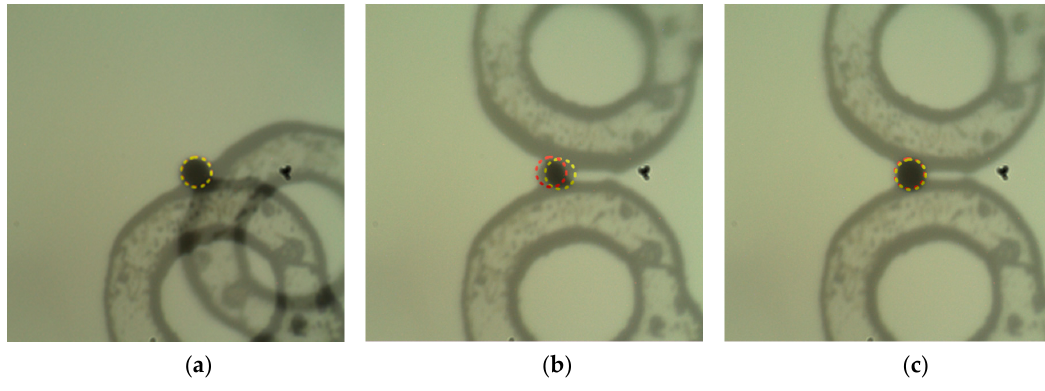
Figure 7. The on-axis viewer images of a 20 μ m diameter ruby sphere mounted on a MiTeGen loop and centred on the φ -axis rotation at the height to bring the sample onto the ω rotation axis. ( a ) An overlay of images with φ at 0° and 180°, and with ω = 0°. The ruby sphere is indicated by the red dashed circle at φ = 0° and the (overlapping) yellow dashed circle at φ = 180°. ( b ) The overlay of images with ω = 0° and φ = 0° (ruby sphere indicated by red dashed circle) and ω = 180° and φ = 0° (ruby sphere indicated by yellow dashed circle) with no correction applied. The displacement of the position of the ruby sphere is 7.5 μ m along the direction of the ω -axis (horizontal). ( c ) The overlay of images with ω = 0° ( φ = 0°) and ω = 180° ( φ = 0°) with the sphere-of-confusion correction applied. The translation of the centre of the ruby sphere (indicated by the red and yellow dashed circles for ω = 0° and ω = 180° respectively) is less than 2 μ m.